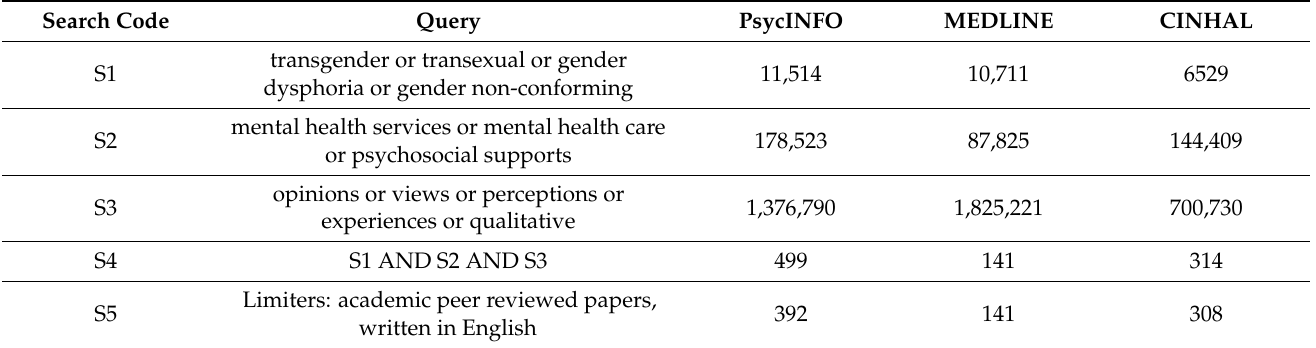
Table 1. Search results across all